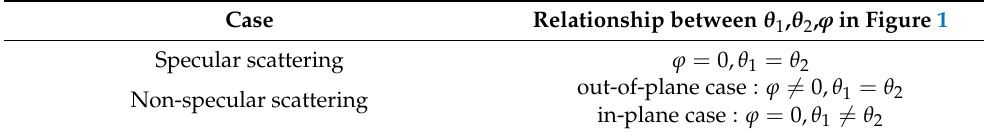
Table 7. Specular scattering case and non-specular scattering case. Case Relationship between θ 1 , θ 2 , ϕ in Figure 1 Specular scattering Non-specular scattering